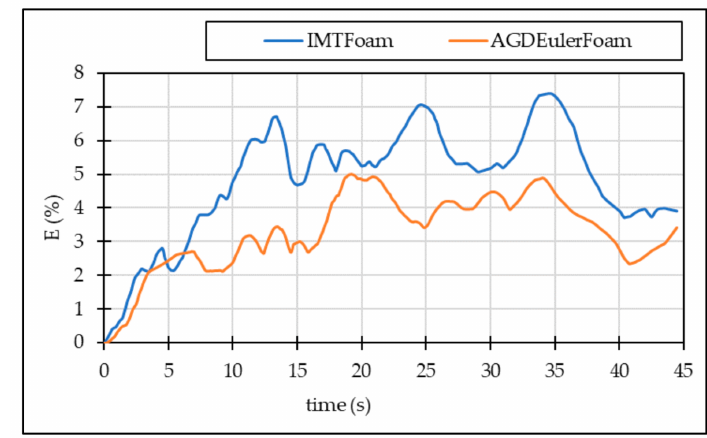
Figure 8. Errors’ evolution of IMTFoam versus AGDEulerFoam .